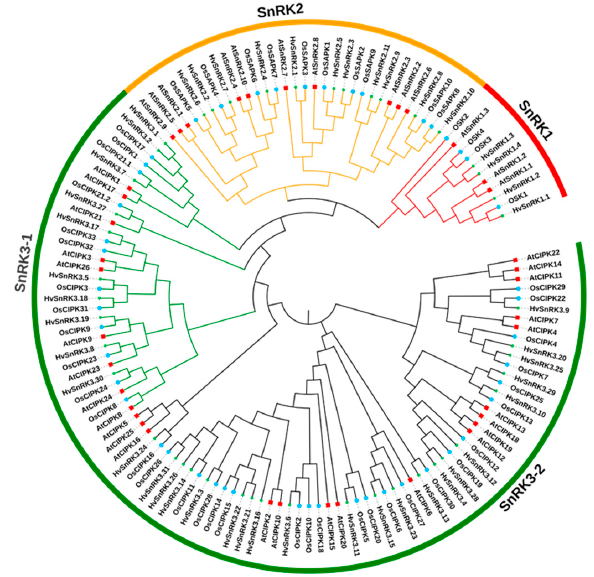
Figure 1. Phylogenetic analysis of SnRK proteins in O. sativa , A. thaliana and H. vulgare . The varied colored arcs represent SnRK protein subfamilies. The 133 SnRK proteins were used to create an unrooted Neighbor-Joining (NJ) phylogenetic tree using MEGA X. The SnRK family proteins from O. sativa , A. thaliana and H. vulgare are represented by the circle, square and star, respectively.